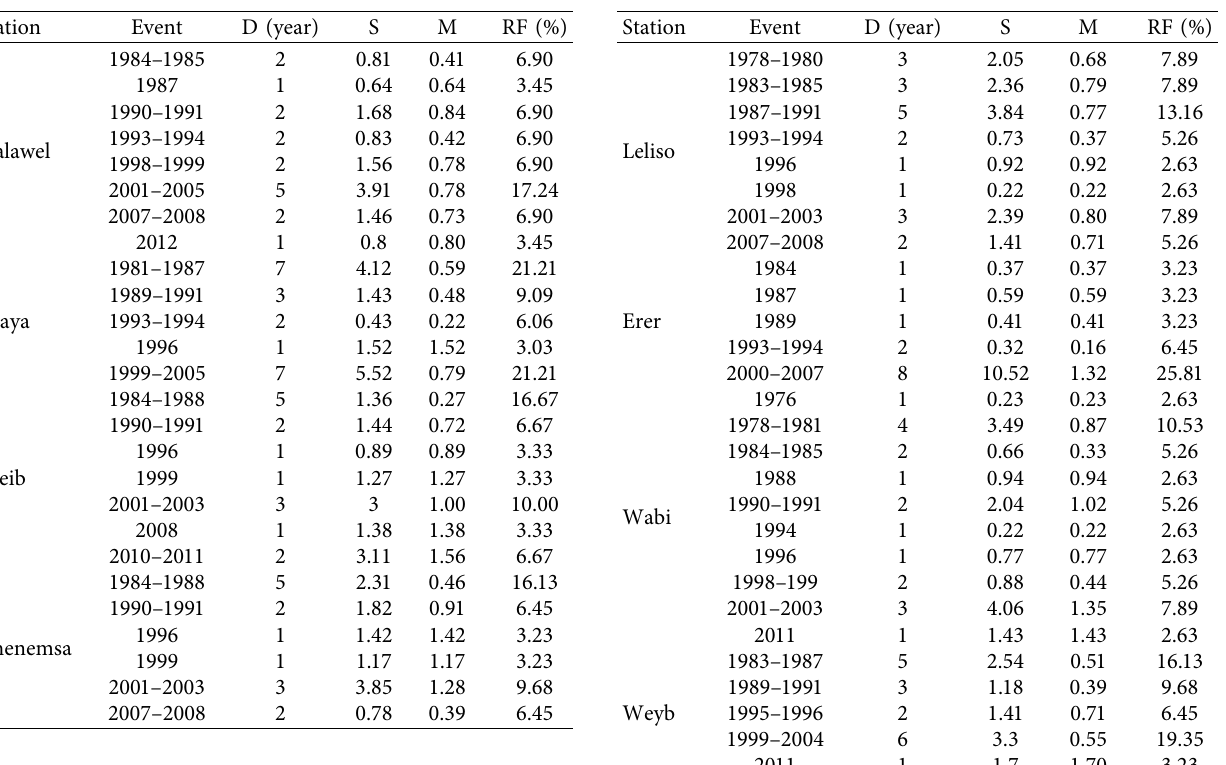
Table 13: Hydrological drought characterization in Ethiopian major river basins, Wabishebele river